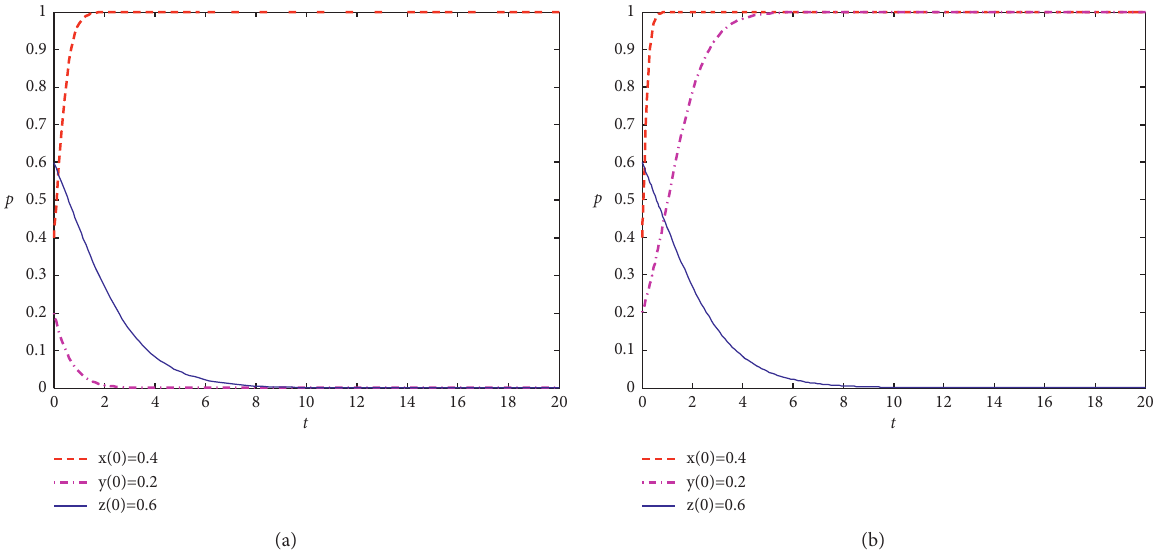
Figure 9: The impact of regulatory authorities’ rewards and penalties for P2P lending platforms on the evolutionary result. (a) w � 0.2, and θ � 0.4. (b) w � 0.4, and θ � 0.8.